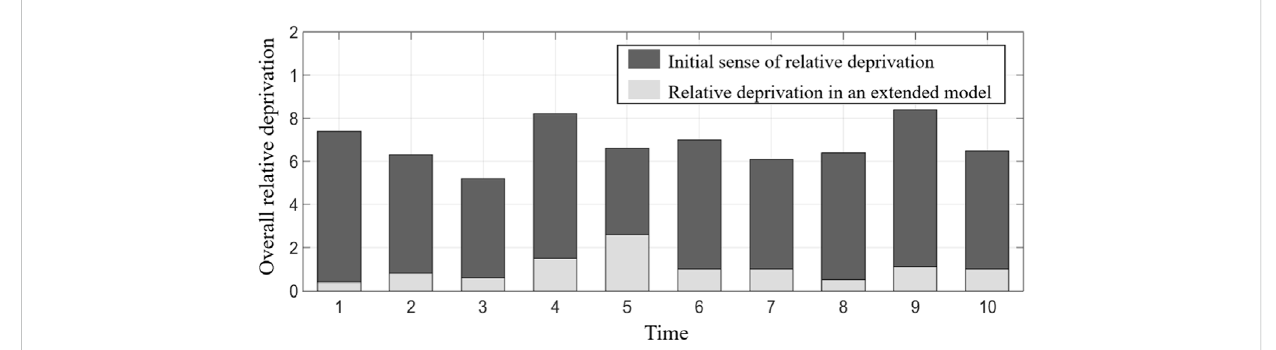
FIGURE 7 Total relative deprivation of member enterprises.